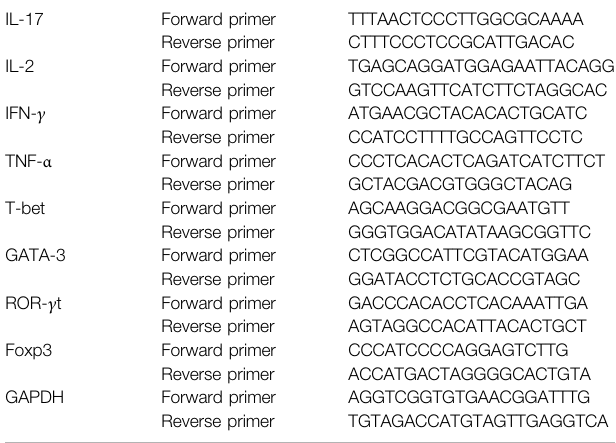
TABLE 1 | Primers for real-time quantitative PCR.